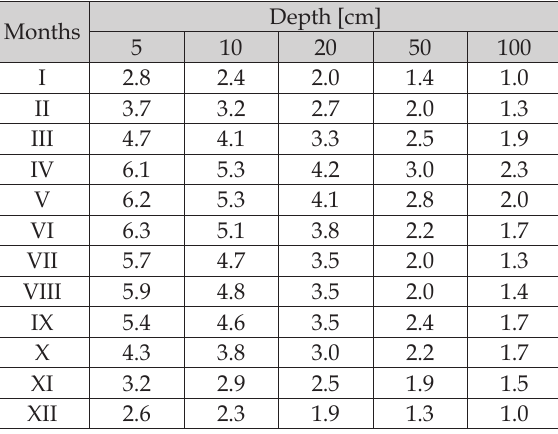
Table 3. The standard deviation of monthly average soil temperature [°C] at various depths in Poznań